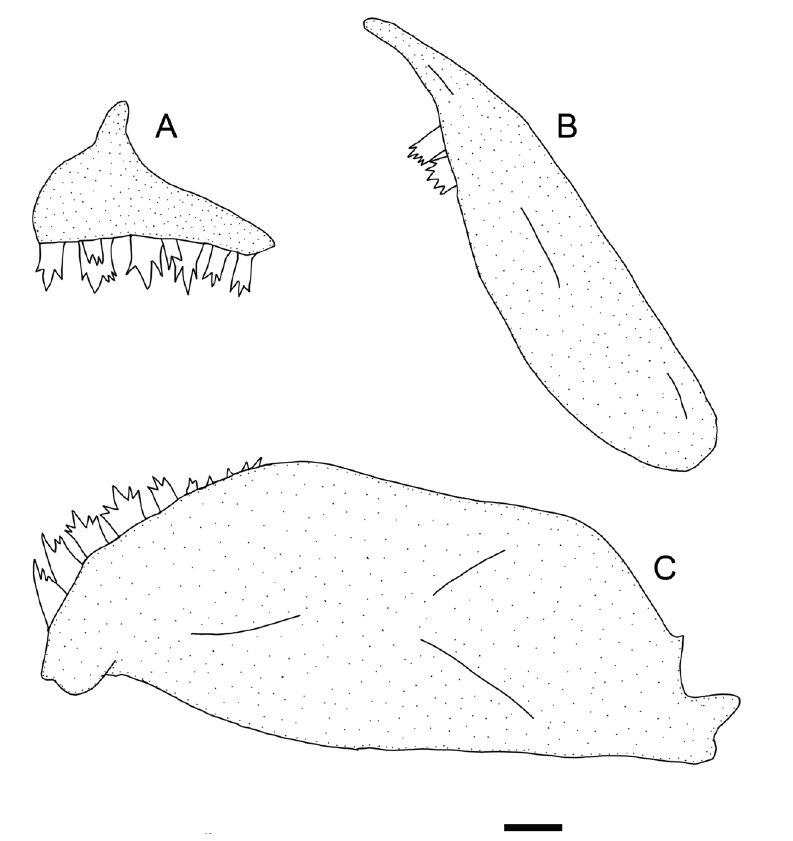
Fig. 2. Hyphessobrycon frickei Guimarães, Brito, Bragança, Katz & Ottoni sp. nov. (CICCAA 02388), 17.7 mm SL; jaw suspensory. A . Premaxillary. B . Maxilla. C . Dentary. Scale bar: 1